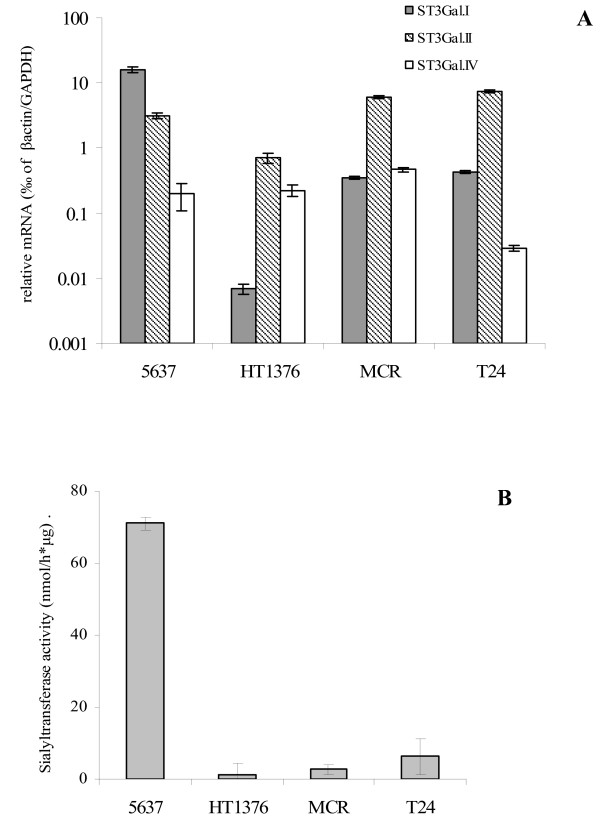
The ST3Gal.I expression correlates with the sialyltransferase activity towards T antigen in bladder cancer cell lines. A: The relative mRNA levels of ST3Gal.I, ST3Gal.II and ST3Gal.IV genes were analyzed in 5637, HT1376, MCR and T24 bladder cancer cell lines, by Real Time PCR. Values infer the number of mRNA molecules of a certain gene per 1000 molecules of the average of the endogenous controls (β-actin and GAPDH). Results are the mean of 3 independent assays. B: The sialyltransferase activity towards Galβ1,3GalNAcα1-O-Benzyl glycoside was assessed in sample homogenates of 5637, HT1376, MCR and T24 bladder cancer cell lines, as described in the Methods section. In the four analyzed bladder cancer cell lines, the ST3Gal.1 mRNA levels are correlated with the observed sialyltransferase activity towards the T antigen (r = 0.99; p = 0.001).